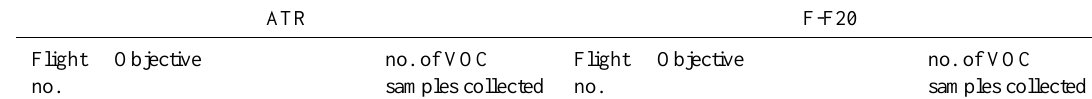
Table 1. Details on ATR-42 and F-F20.